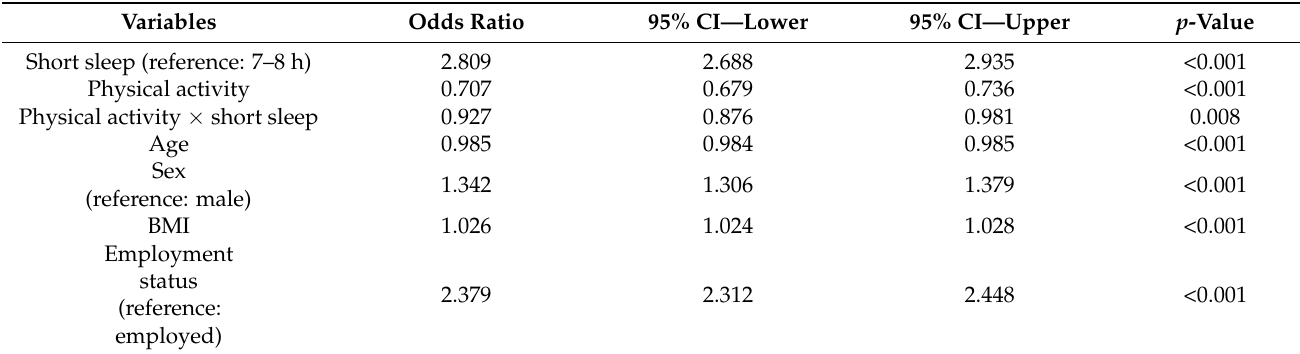
Table 10. The moderating effect of physical activity on the relationship between short sleep compared to healthy sleep and emotional distress among Whites ( n = 227,823).